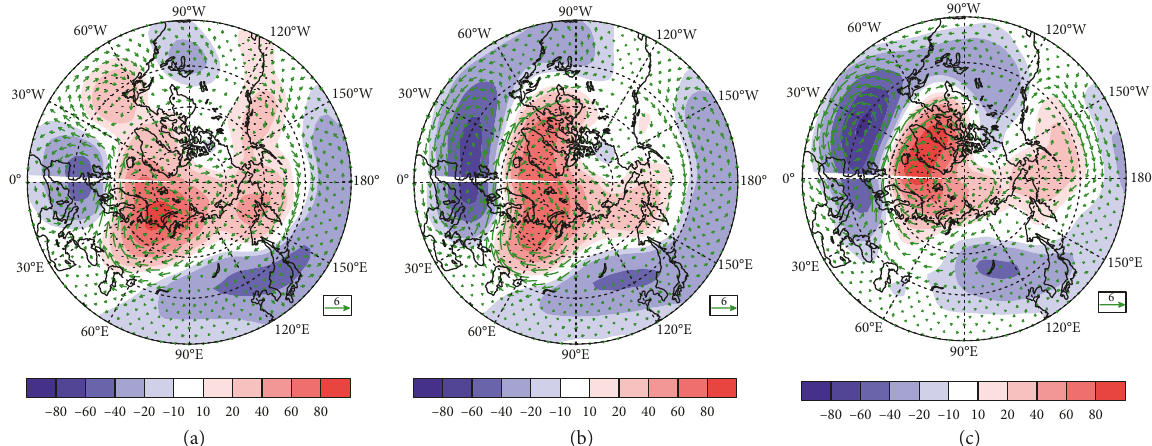
Figure 8: The same as (d), (e), and (f) in Figure 7 but for DJF mean Z500 (shaded) (unit: gpm) and V850 (vector) (unit: m · s − 1 ). The dotted areas denote the values that are statistically significant with significance exceeding 0.1 based on the results of t -tests for